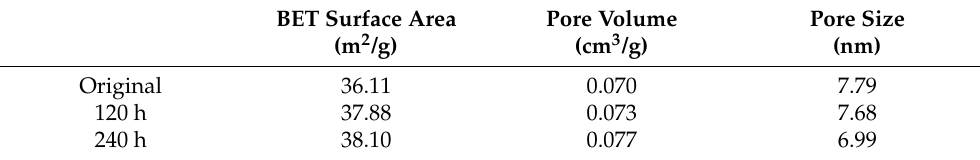
Table 3. Surface area, pore volume, and pore size by N 2 -BET.